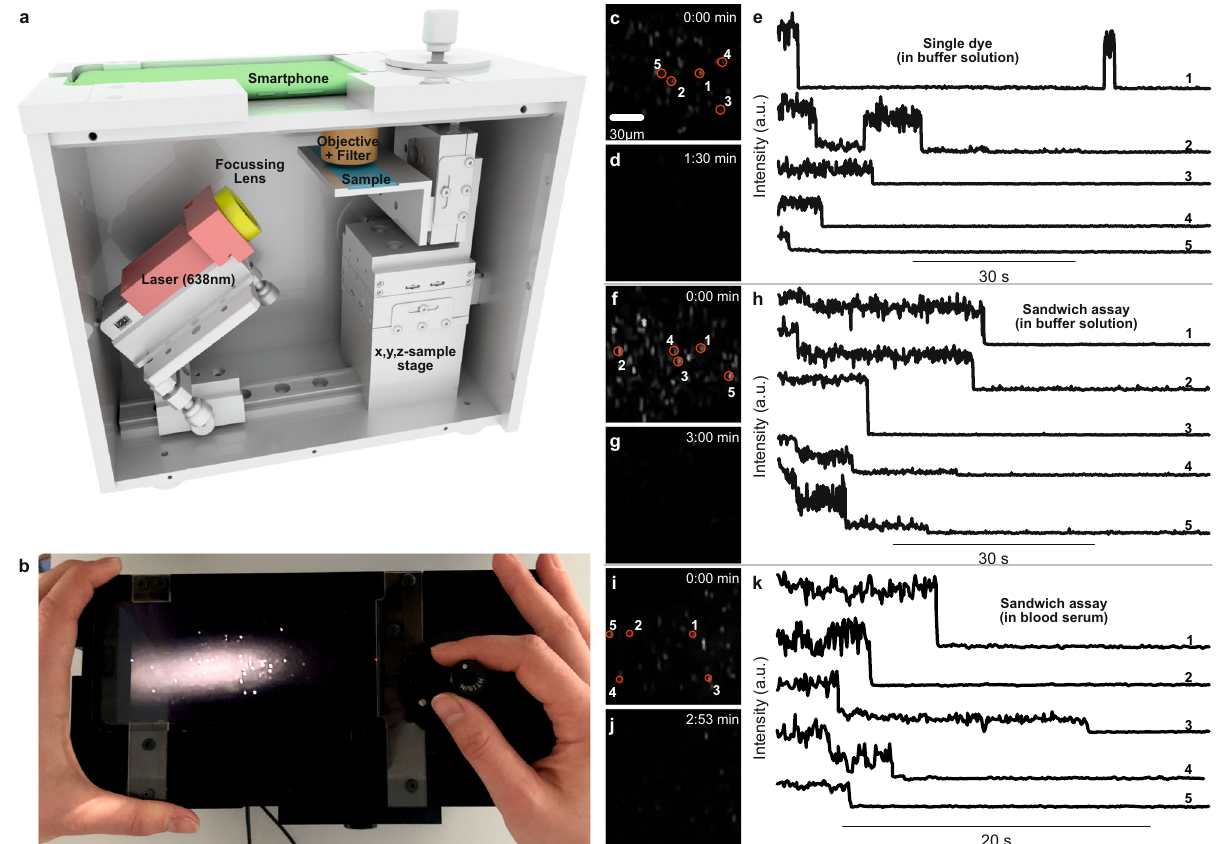
Fig. 3 Single-molecule detection on a portable smartphone microscope. a Sketch of the portable smartphone microscope with the battery driven 638 nm laser (red), the focusing lens ( f = 5 cm) (yellow), the microscope coverslip with the sample (blue), the objective lens and the emission fi lter (brown), and the smartphone monochrome camera as detector (green). b Top view photograph of the portable smartphone microscope. c Background corrected fl uorescence image of NACHOS with 100 nm silver nanoparticles and a single Alexa Fluor 647 dye. d Fluorescence image as in c after illumination for 1:30 min. e Exemplary fl uorescence transients of a single Alexa Fluor 647 in NACHOS measured on the portable microscope setup. Single bleaching steps of dyes and long-time blinking events are visible. f Background corrected fl uorescence image of NACHOS equipped with a sandwich assay with 100 nm silver nanoparticles and Alexa Fluor 647 imager strands. g Fluorescence image as in f after illumination of the area for 3:00 min. h Exemplary fl uorescence transients of Alexa Fluor 647 in a three-capture-strand DNA origami nanoantenna measured on the portable smartphone microscope. i Background corrected fl uorescence image of NACHOS equipped with the sandwich assay with 100 nm silver nanoparticles and Alexa Fluor 647 imager strands after incubation in blood serum. j Fluorescence image as in i after illumination of the area for 2:53 min. k Exemplary fl uorescence transients of Alexa Fluor 647 in a three-capture-strand NACHOS measured on the portable smartphone microscope. Fluorescence transients with one, two, and three bleaching steps (analogous to single-molecule confocal measurements) were observed. The movies represented in the panels c , d , f , g , i and j were reproduced at least 5 times. Three movies for each measurement are provided in the Supplementary Movies. The fl uorescence transients shown in panels e , h and k were extracted from a single